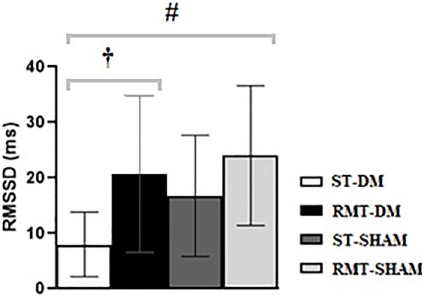
Figure 2. Comparison of root mean square of successive differences between adjacent RR intervals (RMSSD) between groups of rats with streptozotocin-induced diabetes mellitus (DM) or controls (Sham). # w P o 0.05 (ANOVA test followed by Tukey ’ s post hoc test). RMT: respiratory muscle training; ST: without